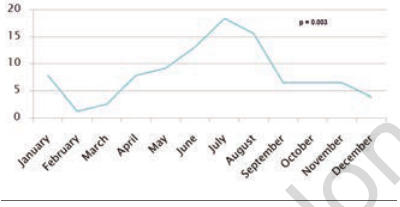
Figure 1. Seasonal variance of the occur- rence of soft tissue staphylococcal infec- tions.